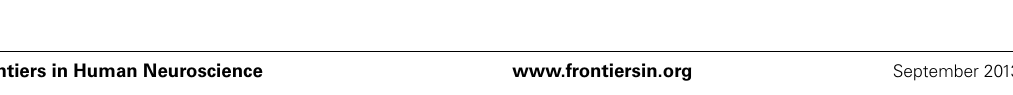
Frontiers in Human